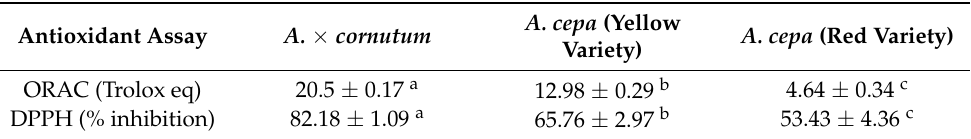
Table 2. Antioxidant potential of A. × cornutum and two varieties of A. cepa L. peel extracts deter- mined by ORAC and DPPH